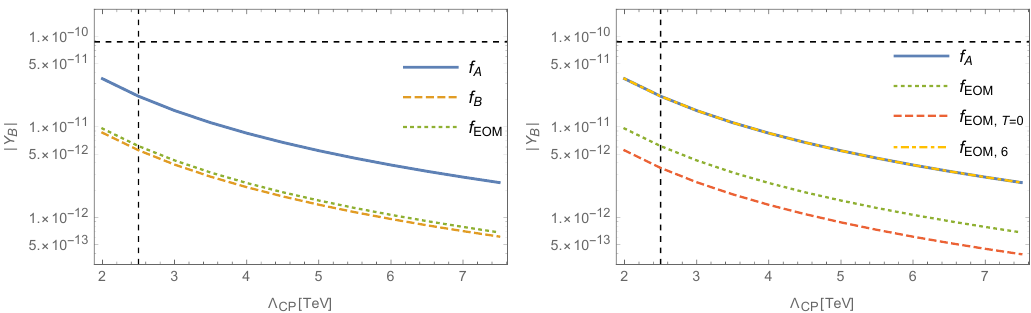
Figure 3 . Absolute value of the baryon asymmetry for the considered dimension-six operators as a function of the e(cid:11)ective CPV scale (cid:3) CP . The vertical line indicates the experimental cuto(cid:11) on (cid:3) CP and the horizontal line indicates the observed value of the baryon asymmetry. while the constraint on (cid:3) from EDM experiments ((cid:3) > 2 : 5 TeV) is depicted by the CP CP vertical dashed line. The asymmetry is proportional to the amount of CP violation, Y / B p ~ c = (cid:3) (cid:0) 2 , thus raising the cuto(cid:11) scale by a factor 2 will decrease the asymmetry by a Y CP factor two. Our results indicate that, given our approximation and input values, scenario A cannot produce the observed asymmetry for cuto(cid:11) scales consistent with the EDM experiments. For the lowest allowed scale (cid:3) = 2 : 5 TeV, the asymmetry is too small CP